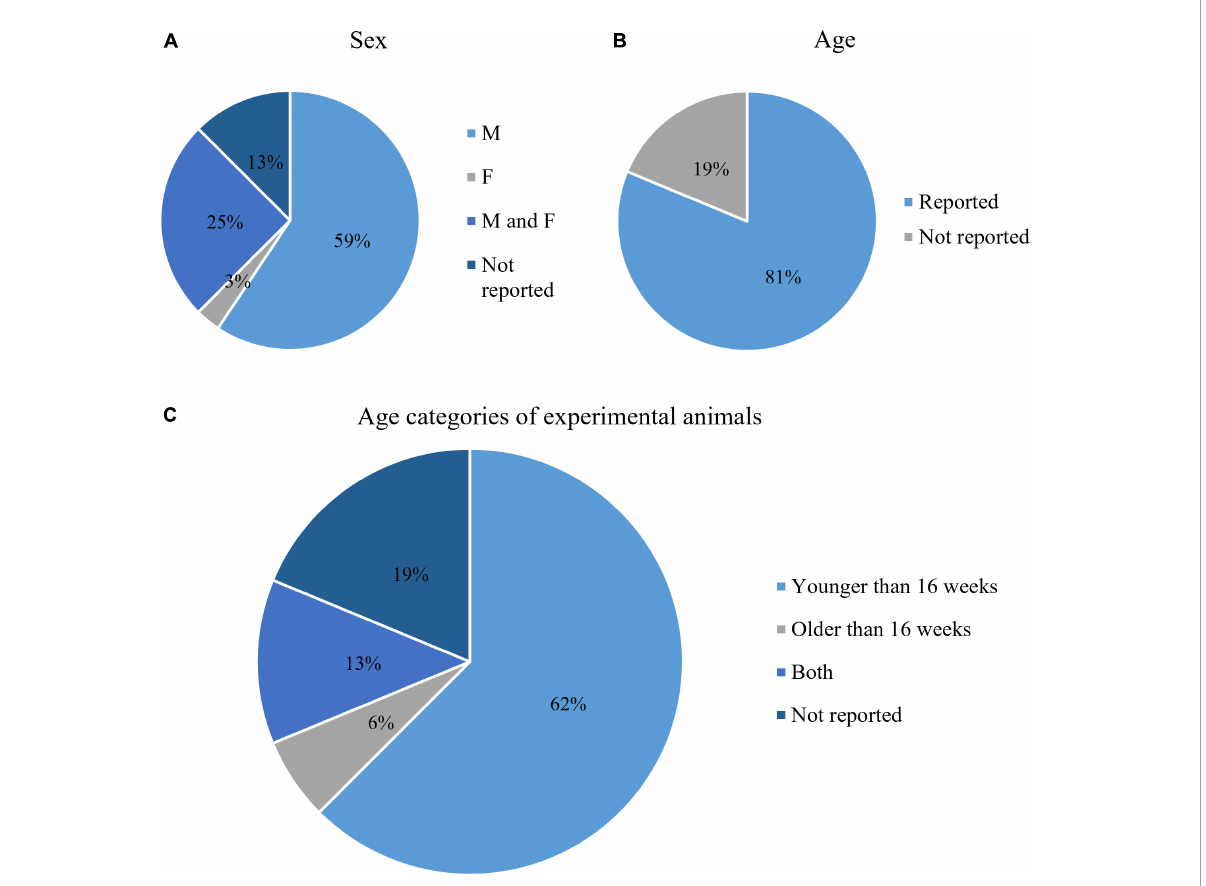
FIGURE3 Characteristics of the animals used in the included studies: Animal sex (A) , whether or not animal age was reported (B) , and age categories (C) .